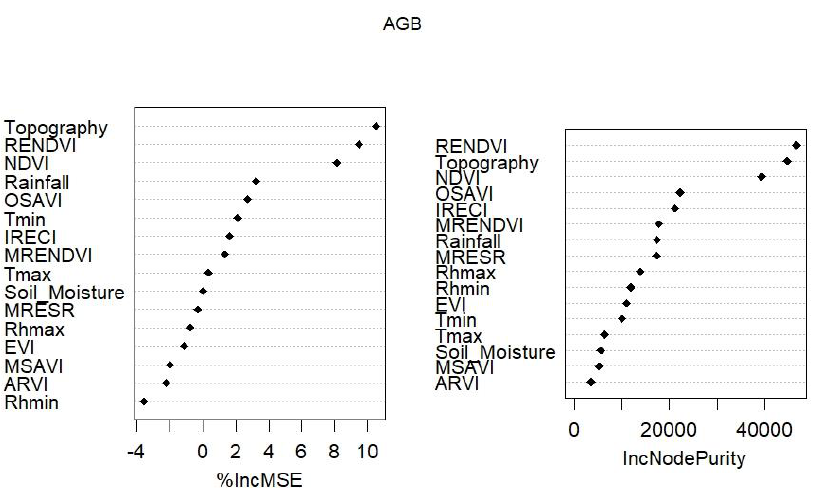
Figure 3. Variable importance plots for random forest regression model. Variable importance plots showing the relative importance of each variable as a predictor of aboveground biomass in the Cross River State, Nigeria. %IncMSE: increasing percentage mean square error. IncNodePurity: increasing node purity.